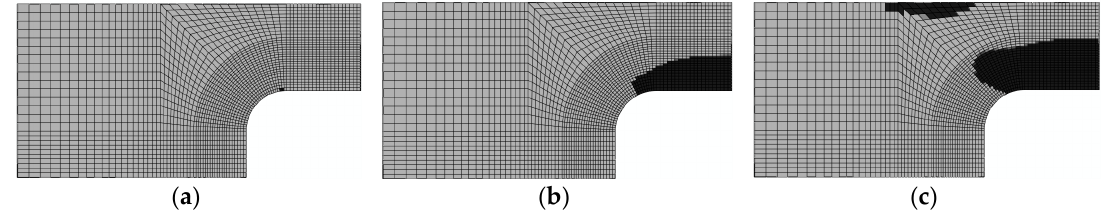
Figure 11. Buckling and kinking damage of unrepaired fiber (0°): ( a ) 98.9 kN; ( b ) 166.2 kN; and ( c ) 192.3 kN. Figure 12. Buckling and kinking damage of repaired fiber (0°): ( a ) 143 kN; ( b ) 178 kN; and ( c ) 213.1 kN.